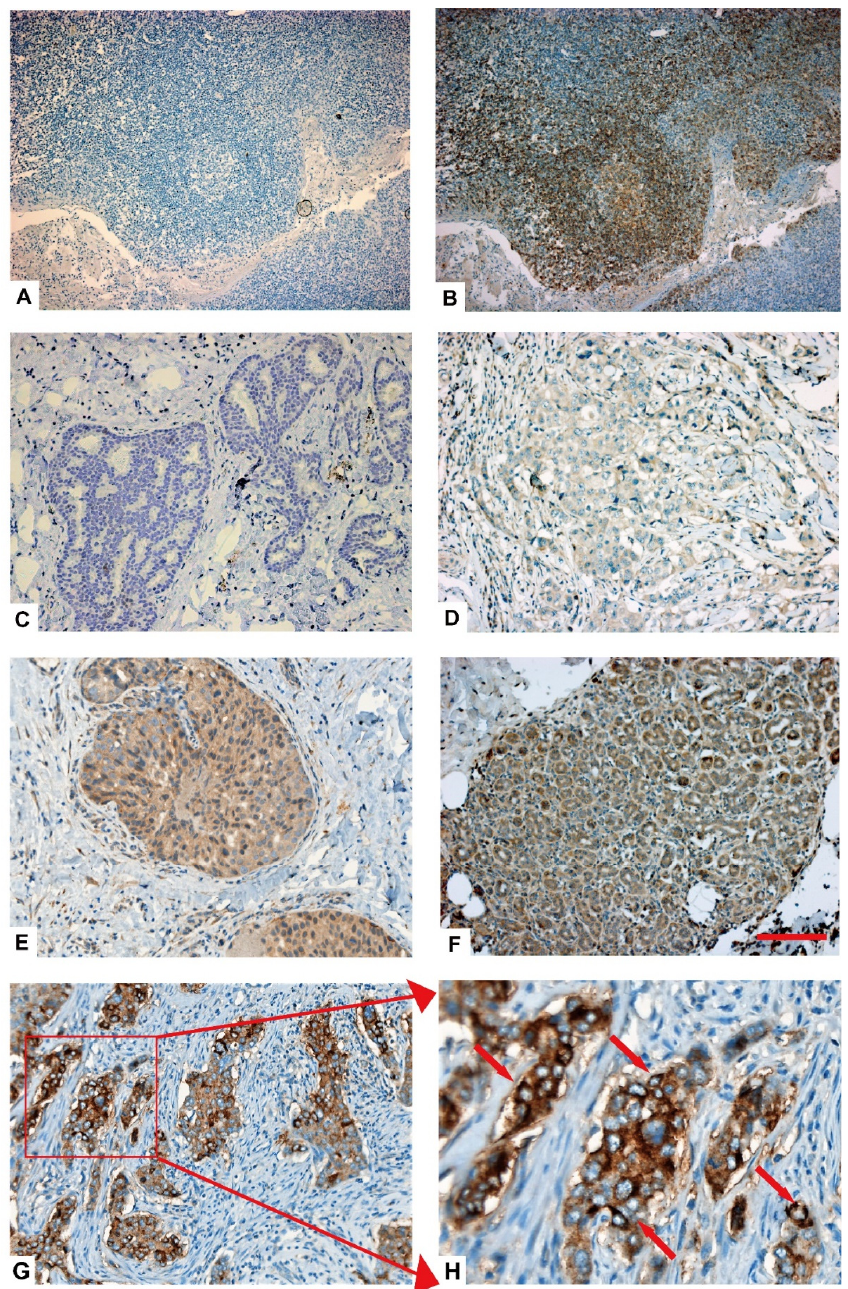
Figure 3. Representative images of immunohistochemical staining of CD22 expression in TNBC specimens. ( A ) Tonsillar carcinoma incubated with PBS showed no signal; ( B ) Tonsillar carcinoma incubated with anti-CD22 antibody showed positive expression for CD22; ( C ) TNBC sample negative for CD22. Relative expression of CD22 in TNBC samples ( D ) weak-positive, ( E ) moderate-positive, ( F ) strong-positive. ( G , H ) Membrane expression of CD22 in TNBC cells. The red arrows marked membrane expression of CD22 in TNBC cells. Magnifications: 20×, Scale bar 100 µm.